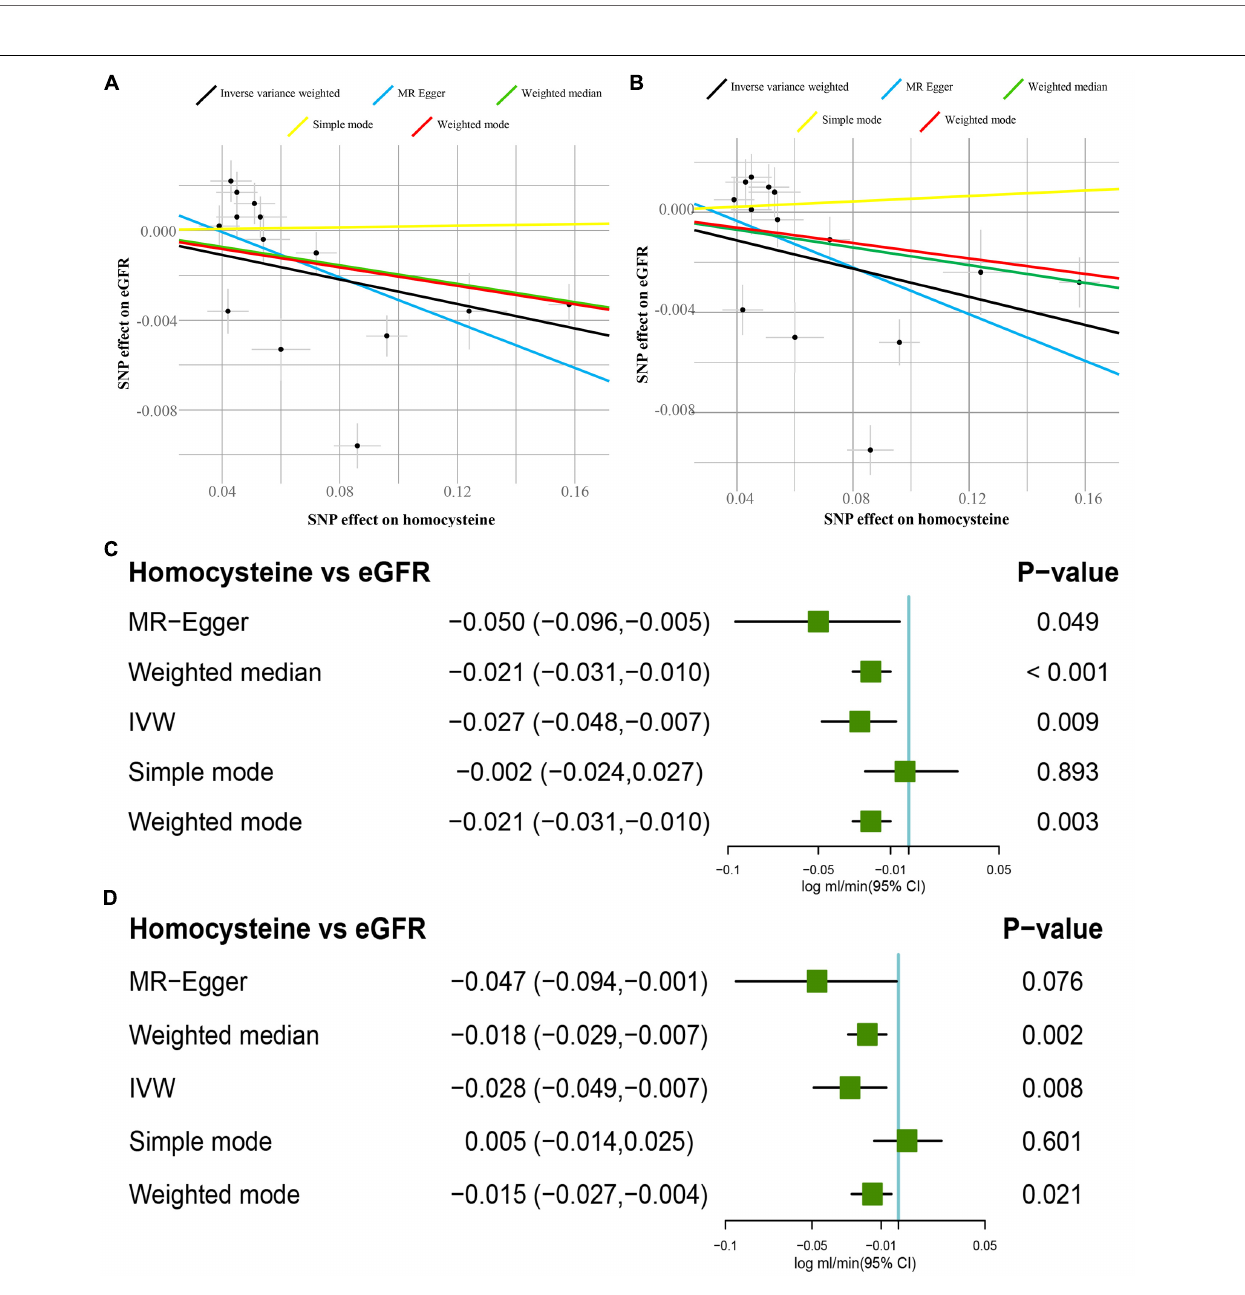
FIGURE 1 | Causal estimates of 1-SD homocysteine (Hcy) increase on eGFR. (A) Scatter plot of the effect size of each SNP on tHcy and eGFR in the CKDGen project with diabetic patients. (B) Scatter plot of the effect size of each SNP on tHcy and eGFR in the CKDGen project excluding the patients with diabetes. (C) Results of the Mendelian randomization (MR) analyses estimating the causal association between 1-SD tHcy increase and eGFR in the CKDGen study with diabetic patients. (D) Results of the MR analyses estimating the causal association between 1-SD tHcy increase and eGFR in the CKDGen study excluding the patients with diabetes. “TwoSampleMR” package in R 3.6.5 was used to perform MR analyses. SD, standard deviation; tHcy, total homocysteine; IVW, inverse variance weighted method; eGFR, estimated glomerular filtration rate; SNP, single nucleotide